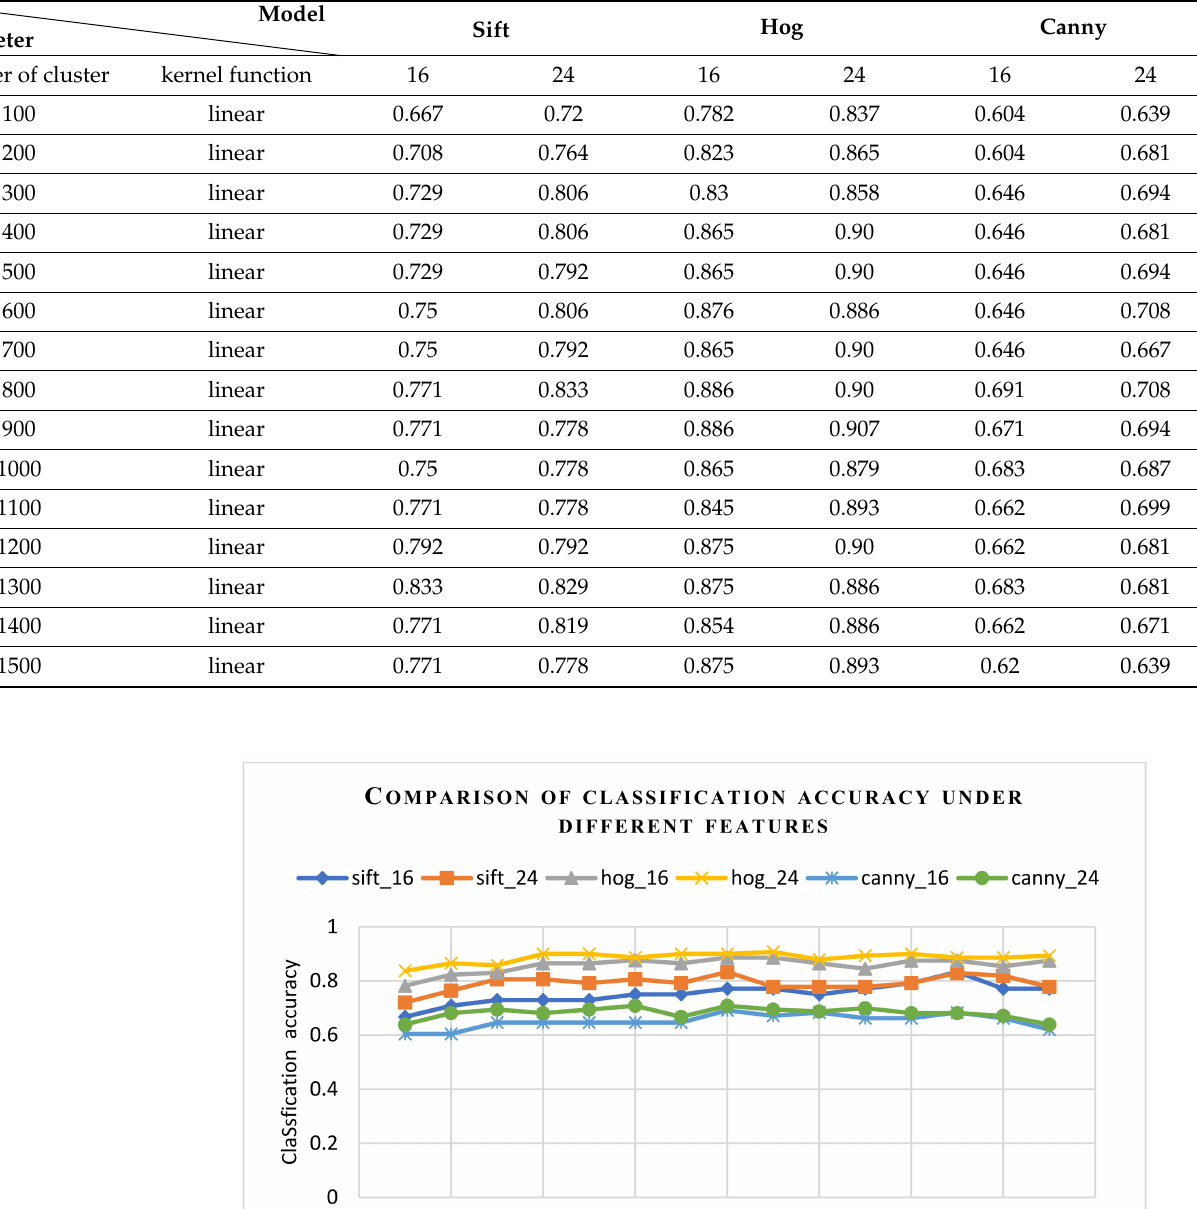
Table 2. Classification accuracy of SVM verification set under different characteristics.